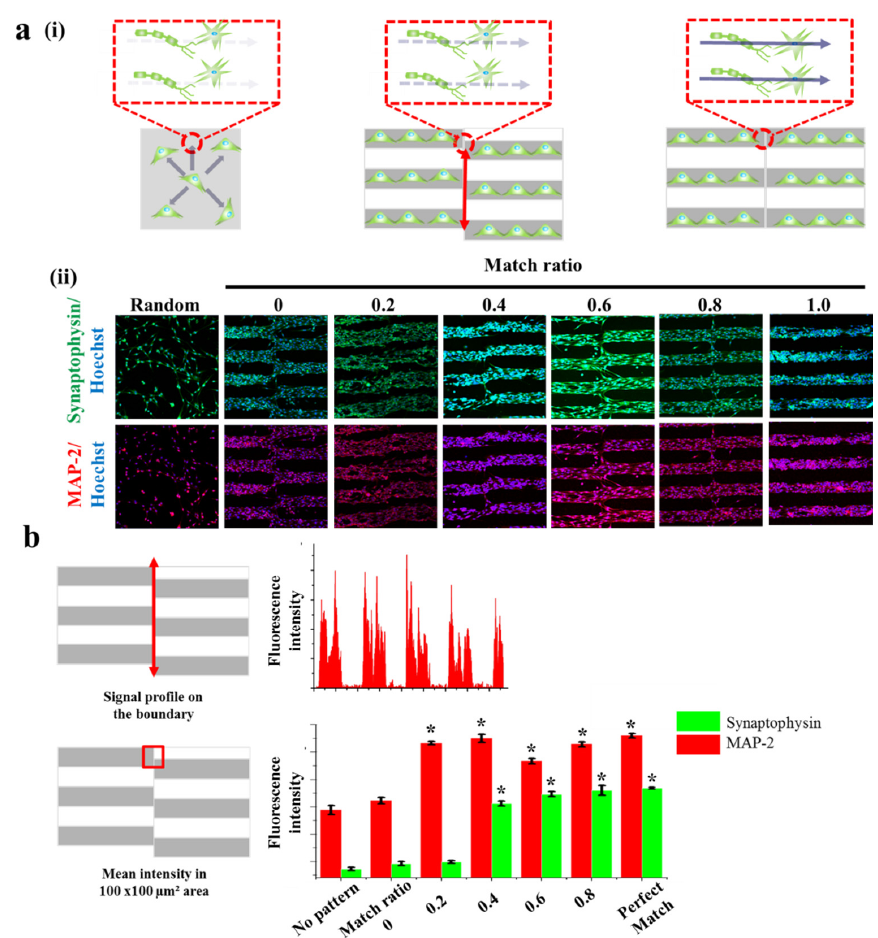
Figure 5. Synaptogenesis guidance due to pattern effect. ( a ) Schematic diagram of cell signal transduction in no pattern, mis ‐ aligned GO hybrid pattern and perfectly matched GO hybrid pattern respectively ( i ). Confocal images of SH ‐ SY5Y cells on no pattern, mis ‐ aligned GO hybrid pattern (match ratio of 0, 0.2, 0.4, 0.6, 0.8) and perfectly matched GO hybrid pattern stained for synapse (green) and nucleus (blue) (top row), cytoskeleton (red) and nucleus (blue) (bottom row) after 2 days of culture ( ii ). ( b ) Signal profile on the boundary of mis ‐ aligned part. Fluorescence intensity of synaptophysin is only shown on the patterned cell part. Quantitative comparison of synaptophysin and MAP-2 fluorescence intensity in 100 μ m × 100 μ m area of mis ‐ aligned section. Data are the mean ± standard deviation of three different experiments. (Student’s t ‐ test, n = 3, * p < 0.05).